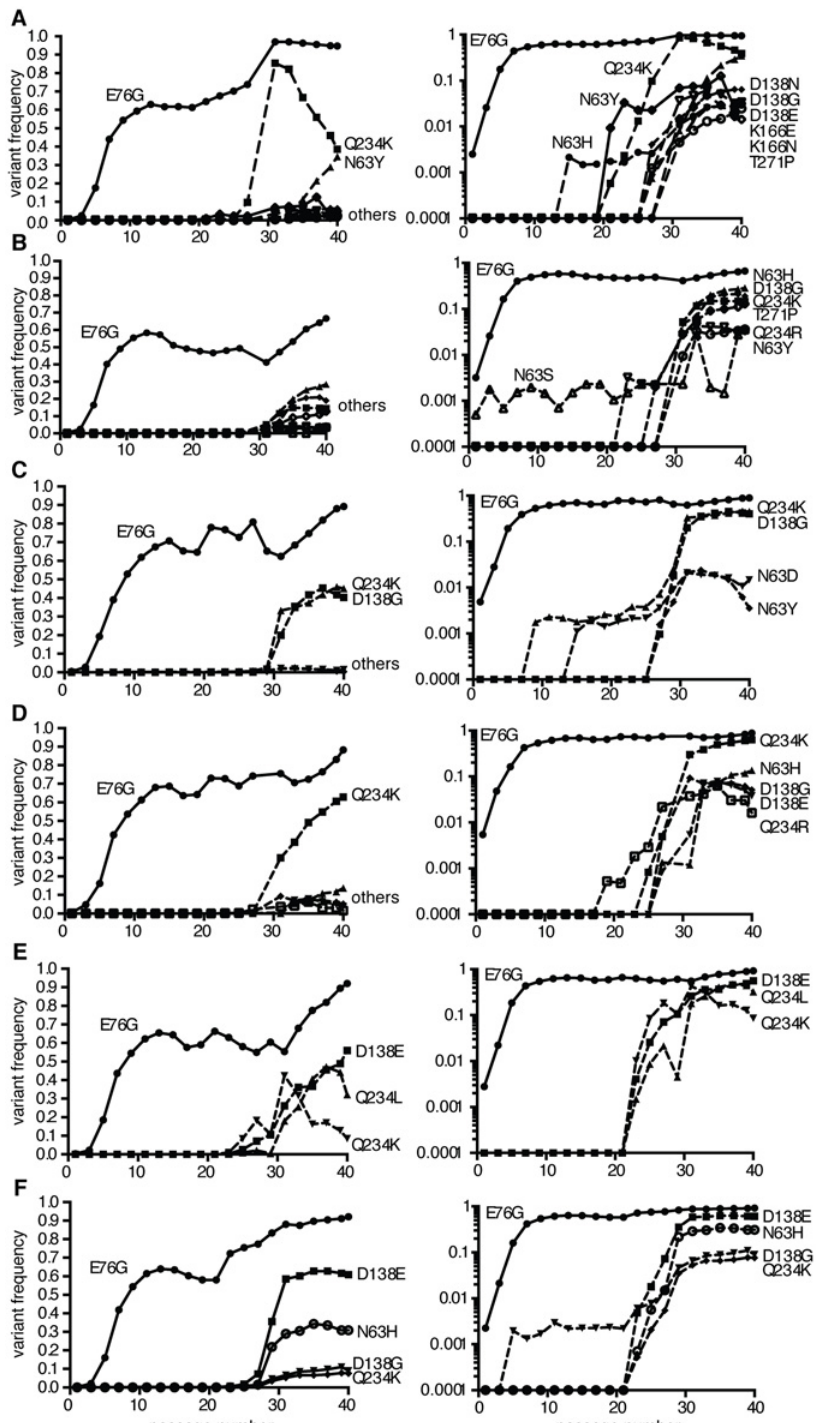
Fig 3. Population sequencing reveals multi-step adaptation of residues in the DAF-specific footprint during passage in A549 cells. (A-F) The virus populations were purified and deep sequenced for each replicate every two passages (p1, 3, 5, 7, etc...) across the P1 region coding for the four capsid proteins. The variant frequencies were determined by the ViVAN pipeline and all statistically significant mutations that showed a trend of increasing frequency were plotted in linear scale (left panels) and log scale (right panels).